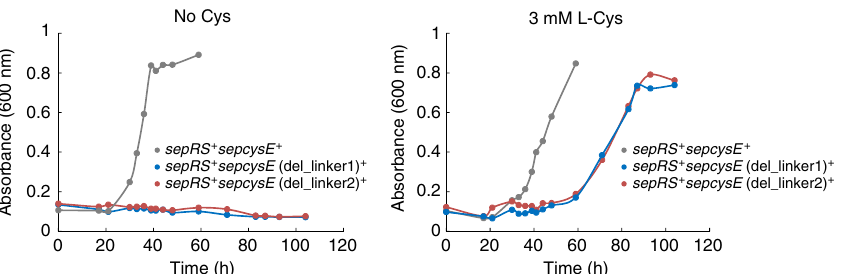
Fig. 6 Growth curves of M . maripaludis variants showing the vital importance of the two linkers of SepCysE. Linker deletion variants are lethal in the absence of Cys (left), which can be rescued by adding 3 mM L-Cys (right) to the medium. This result suggests an essential role of the linkers for the synthesis of Cys-tRNA Cys . The inocula were 10 5 cells per 5 ml culture. Each growth curve is a representative of triplicates. The sepRS + sepcysE + , sepRS + sepcysE (del_linker1) + , and sepRS + sepcysE (del_linker2) + strains represent the Δ sepRS Δ sepcysE double deletion mutant strain supplemented with SepRS/SepCysE (WT), SepRS/SepCysE(del_linker1), SepRS/SepCysE(del_linker2) expressed from a vector, respectively. The SepCysE(del_linker1) is a M . maripaludis SepCysE mutant with Q28-N35 deleted, and the SepCysE(del_linker2) is a SepCysE mutant with